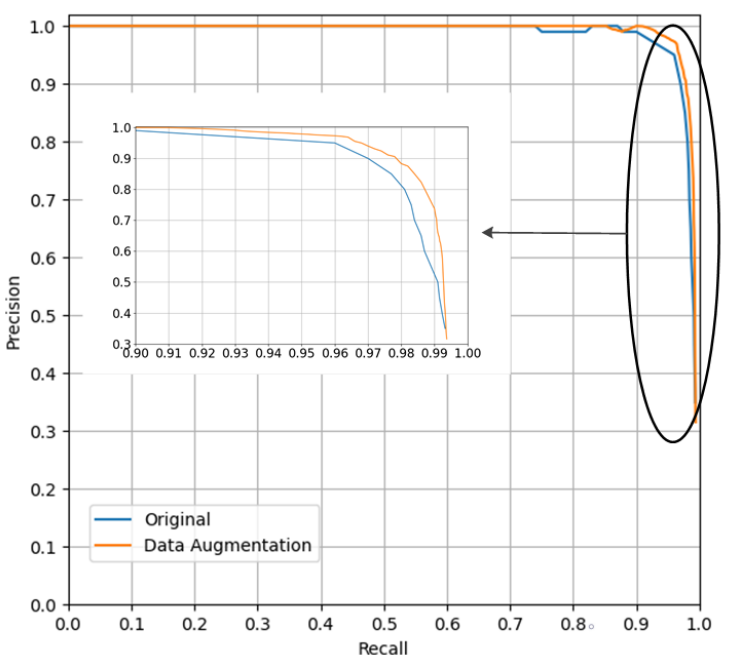
Figure 15. P-R curves of the YOLO-SC model for two datasets (top left is a magnification of the circled part on the right).